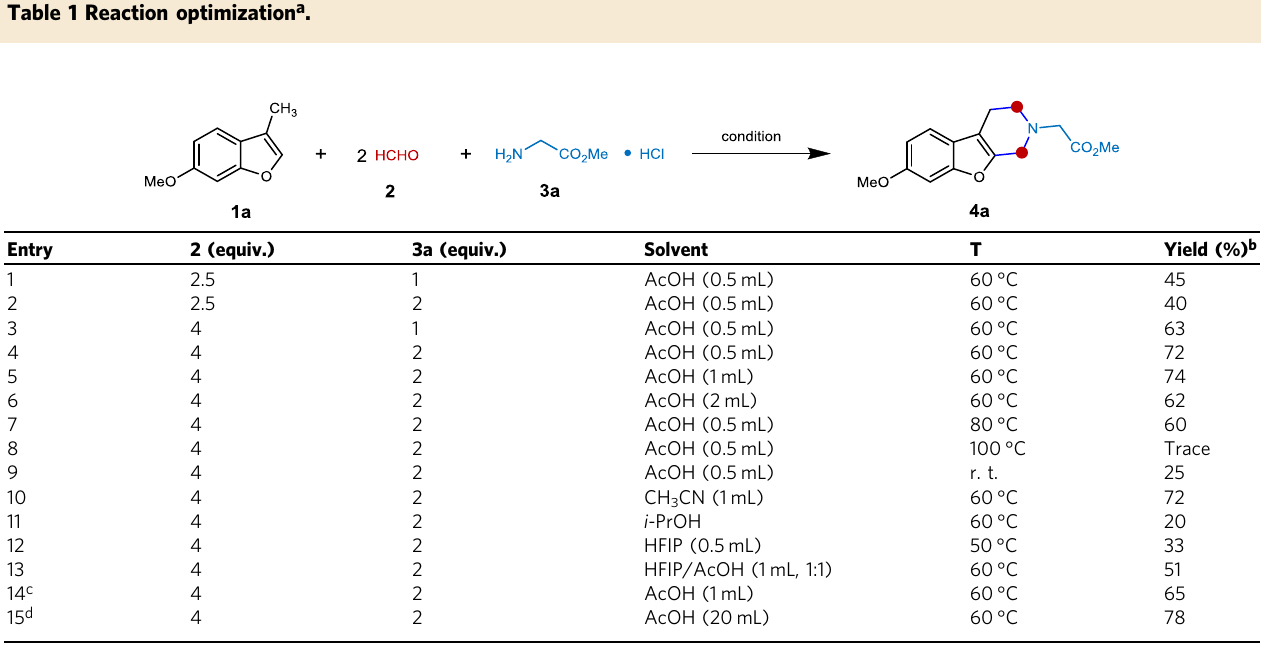
Table 1 Reaction optimization a